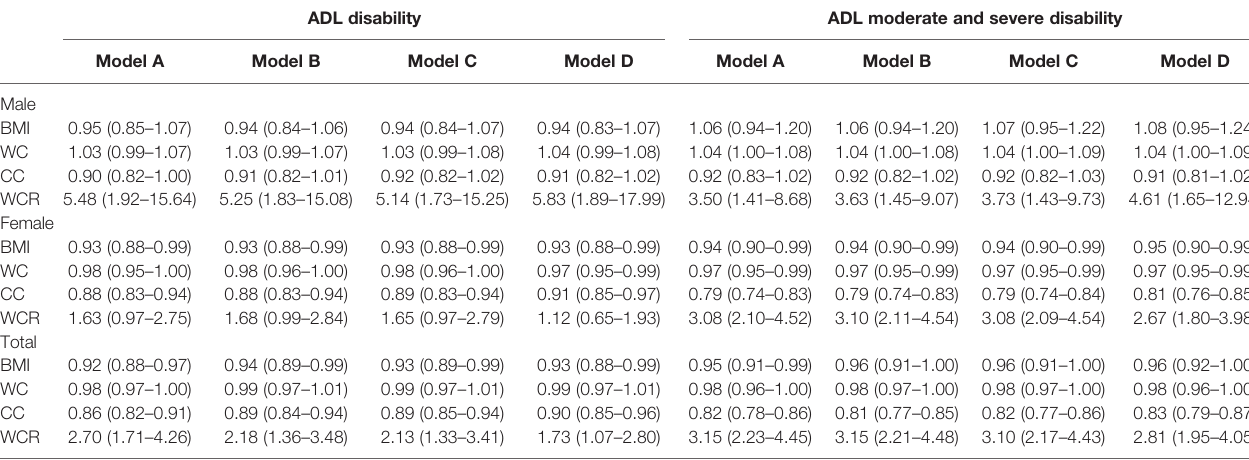
TABLE 2 | The odds ratios for activity of daily (ADL) disability and moderate and severe ADL disability.